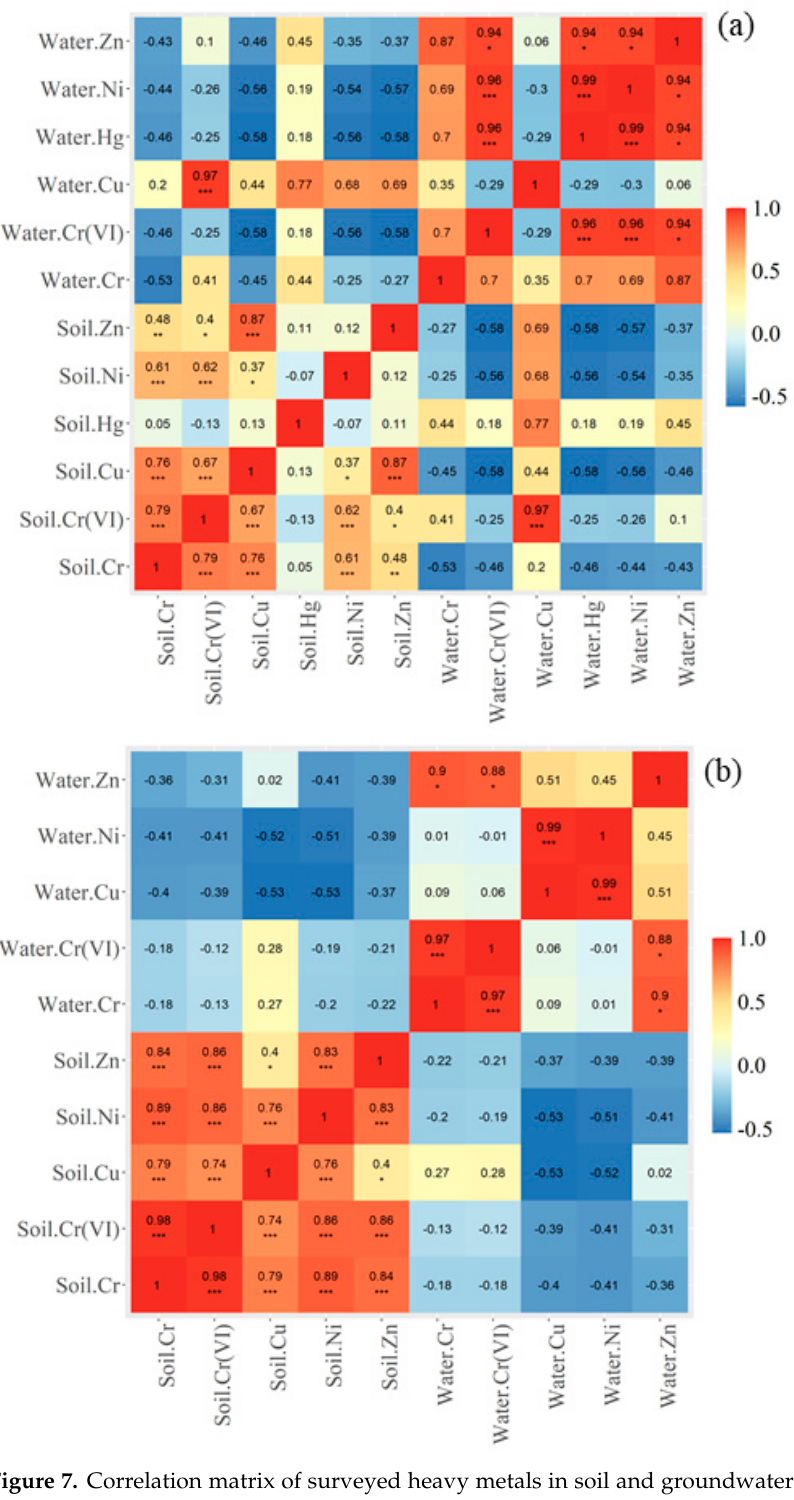
Figure 7. Correlation matrix of surveyed heavy metals in soil and groundwater for ( a ) Factory A, ( b ) Factory B. Dotted cell denotes significant correlation (* p ≤ 0.5, ** p ≤ 0.01, *** p ≤ 0.001).